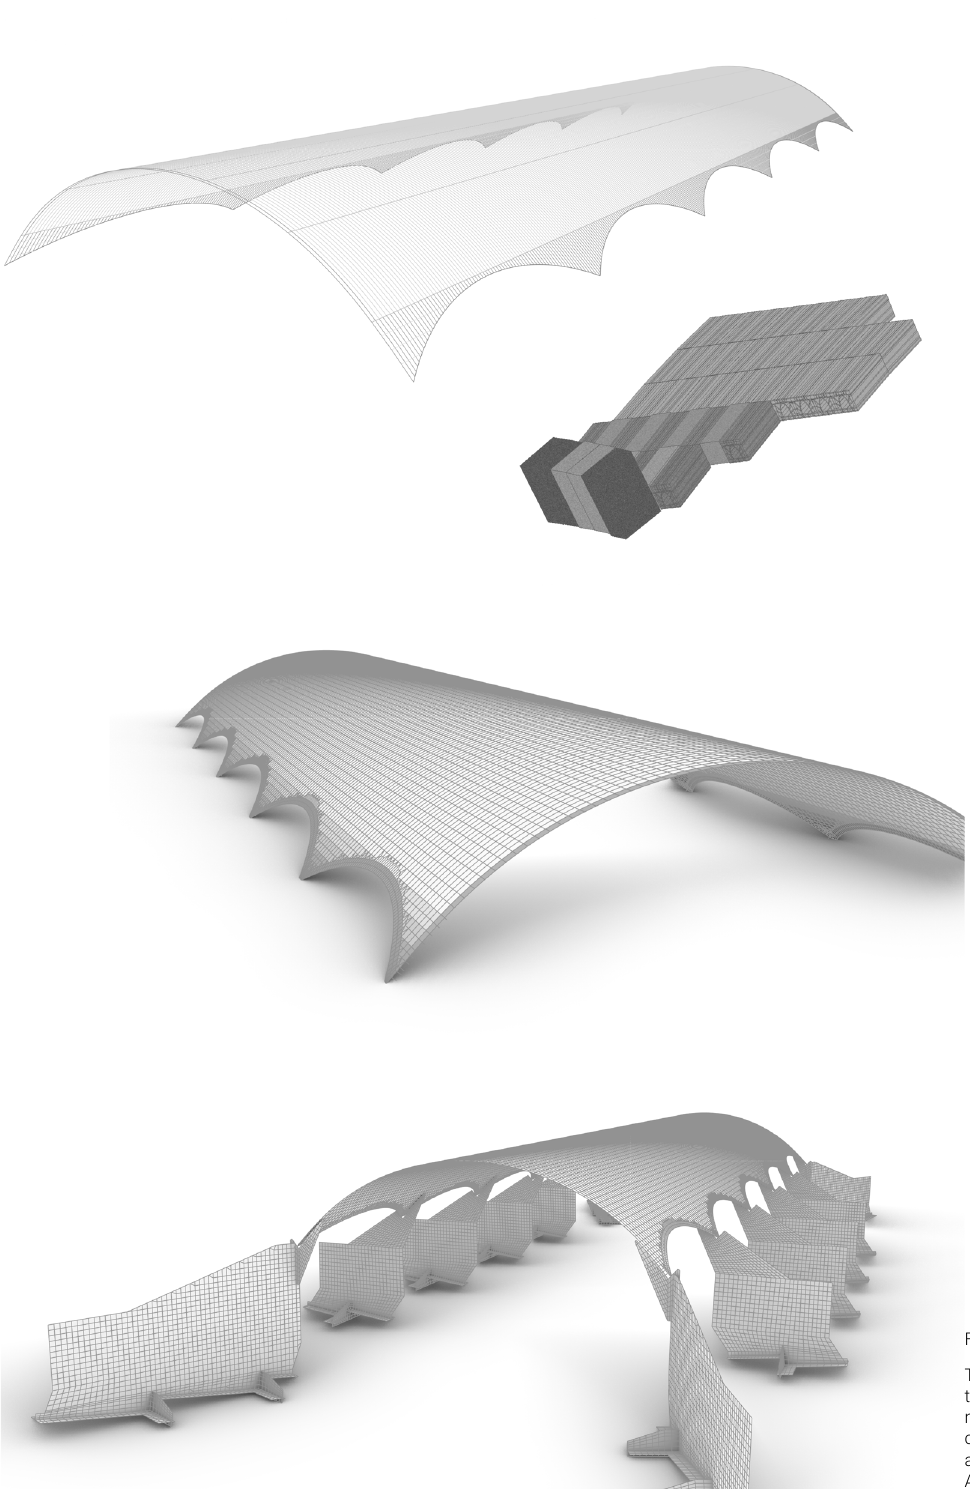
Top to bottom: 3D models of the vault, including the con- necting gables and side arches, created using beam elements and plate elements (author: Alice